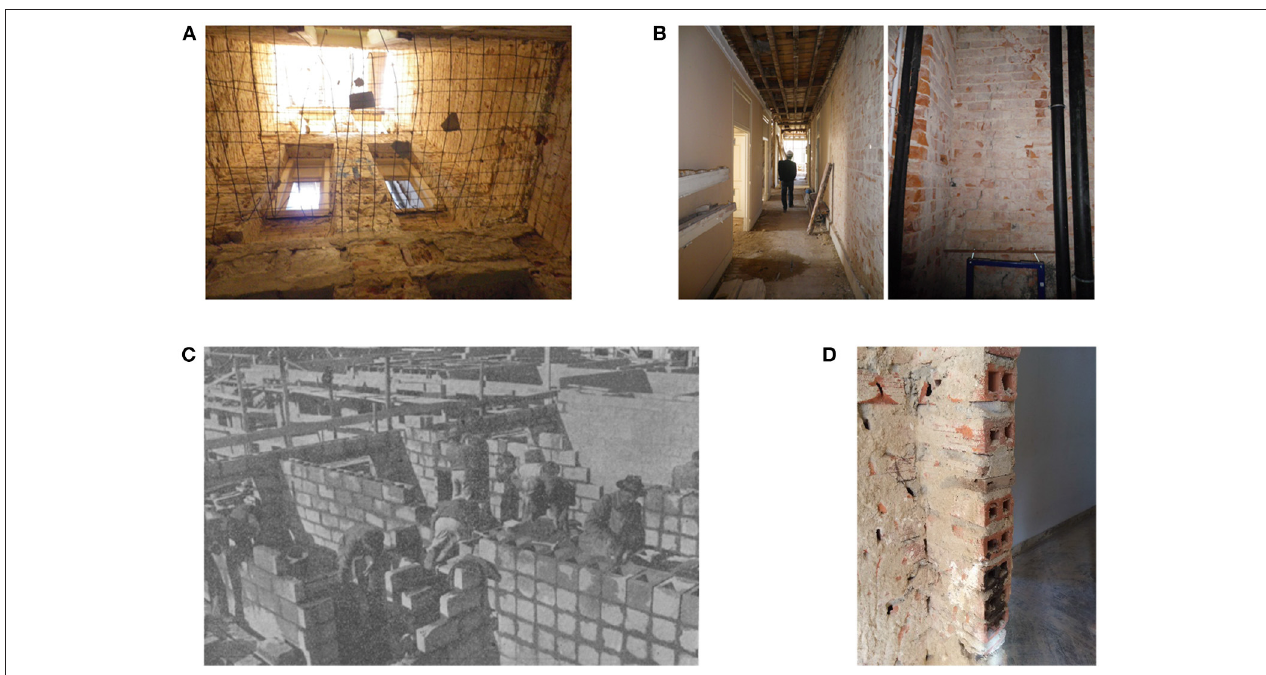
FIGURE 5 | Masonry walls with different type of materials. (A) Rubble stone, (B) Brick, (C) Concrete block, (D) Connection between